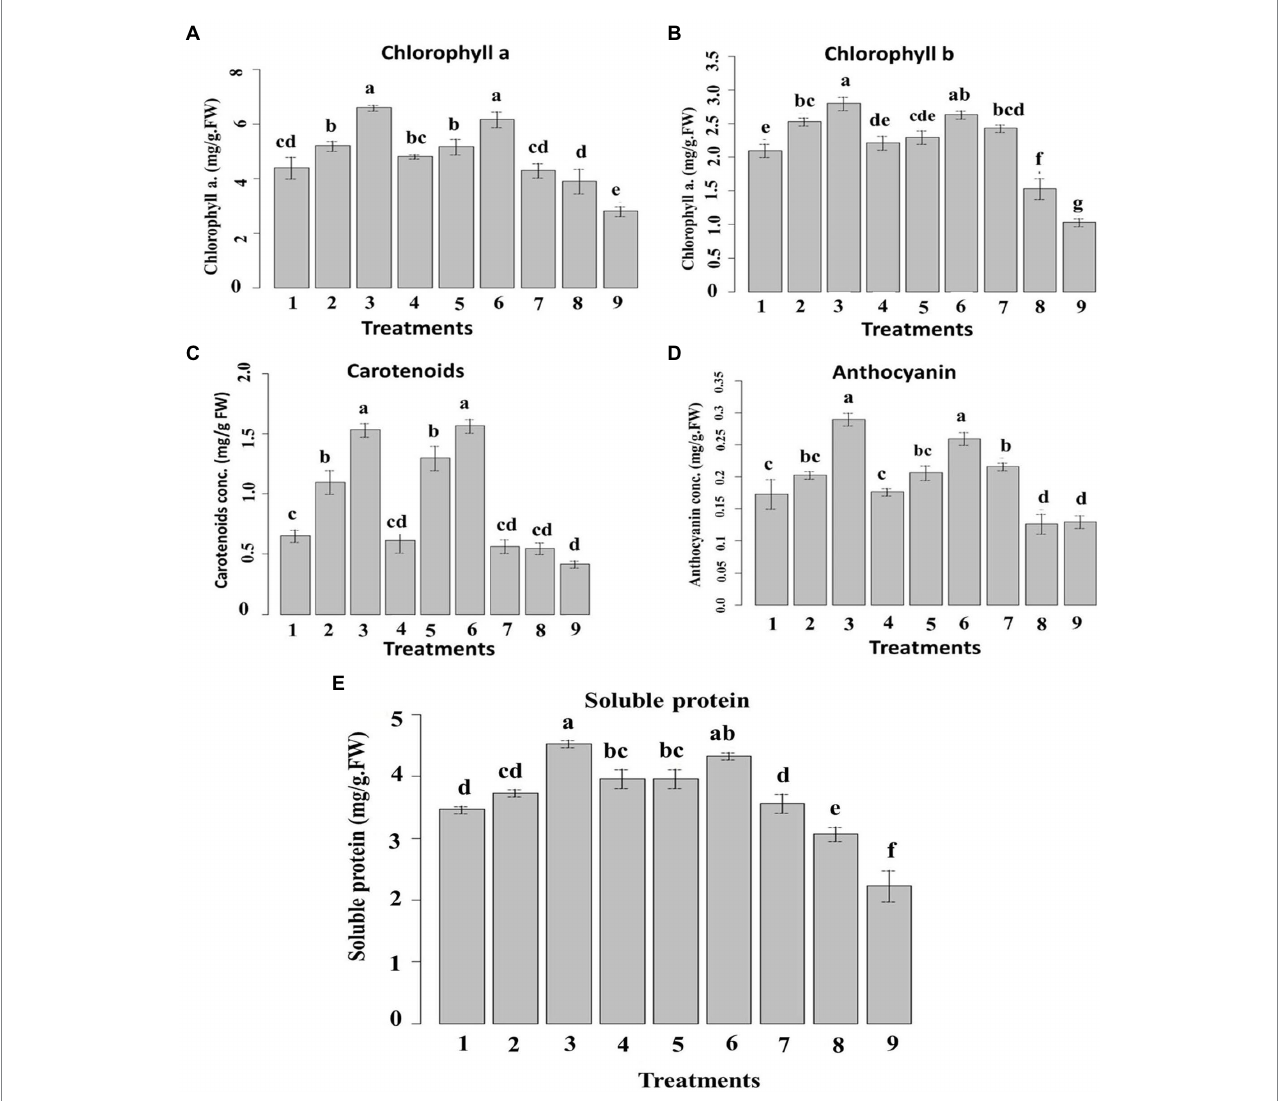
FIGURE 10 Effect of six nanoemulsions treatments on (A) chlorophyll a, (B) chlorophyll b, (C) carotenoid, (D) anthocyanin, and (E) soluble protein content in maize leaves compared to the chemical fungicide and (positive and negative) controls. 1–6 are 0_T80, 5_T80, 10_T80, 0_T20, 5_T20, and 10_T20, respectively. 7–9 are chemical fungicide, untreated control, and infected control, respectively. Values marked with the same letters are not statistically different according to post hoc test DMRT at p ≤